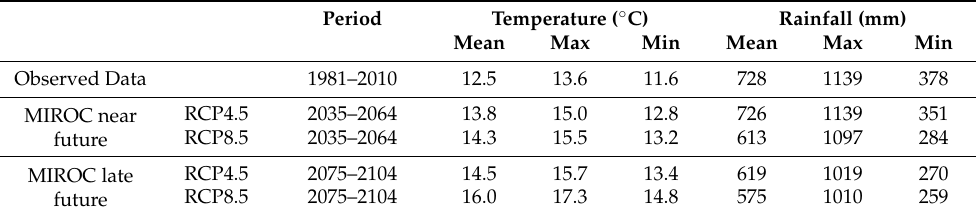
Table 1. Annual rainfall and temperature